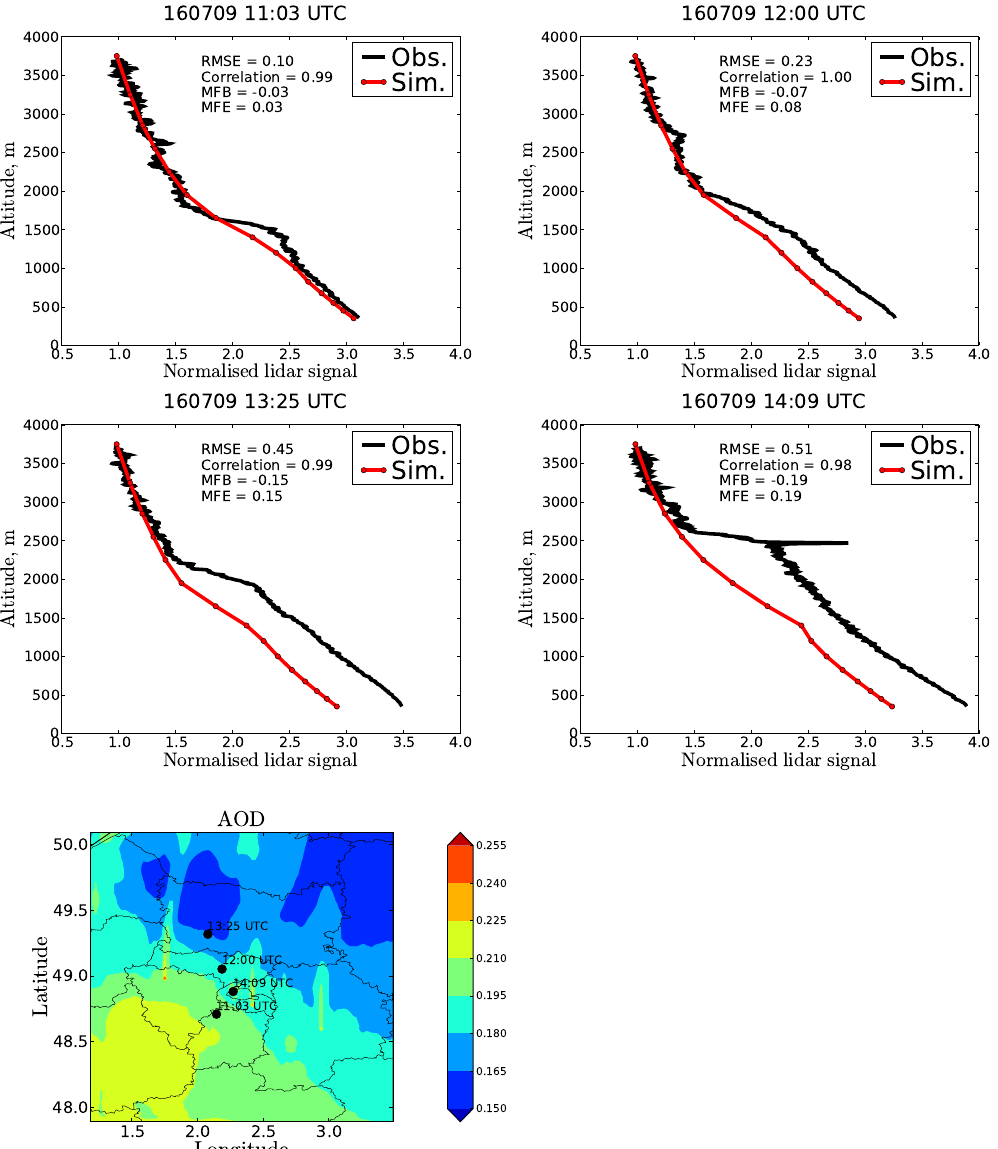
Fig. 6. Comparisons between the vertical profiles observed by GBML (black lines) and simulated by P OLYPHEMUS (red lines) on 16 July 2009 at 11:03, 12:00, 13:25 and 14:09UTC. Lidar observations below the altitude of full overlap are not represented. The lower-left panel shows the positions of the different lidar profiles and the horizontal distribution of the mean of the AODs at 11:00, 12:00, 13:00 and 14:00 UTC.